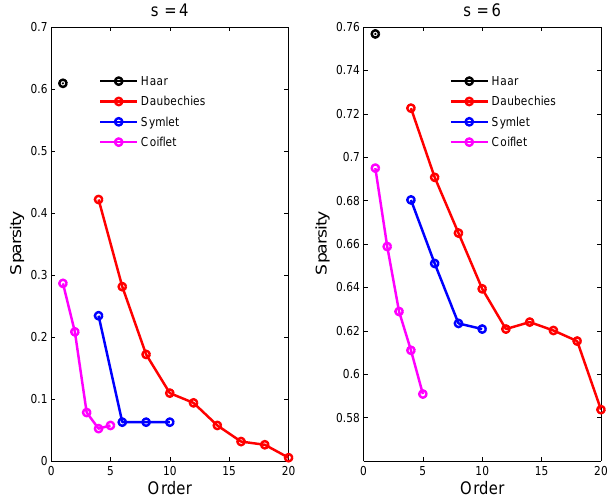
Figure 2. Sparsity of representation at scale s = 4 (left) and s = 6 (right) for a combination of wavelet families and orders. We find that Haar provide the sparsest